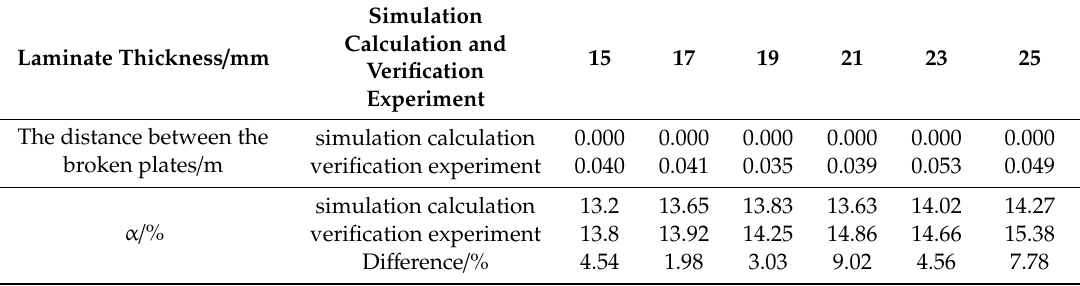
Laminate Thickness / mm